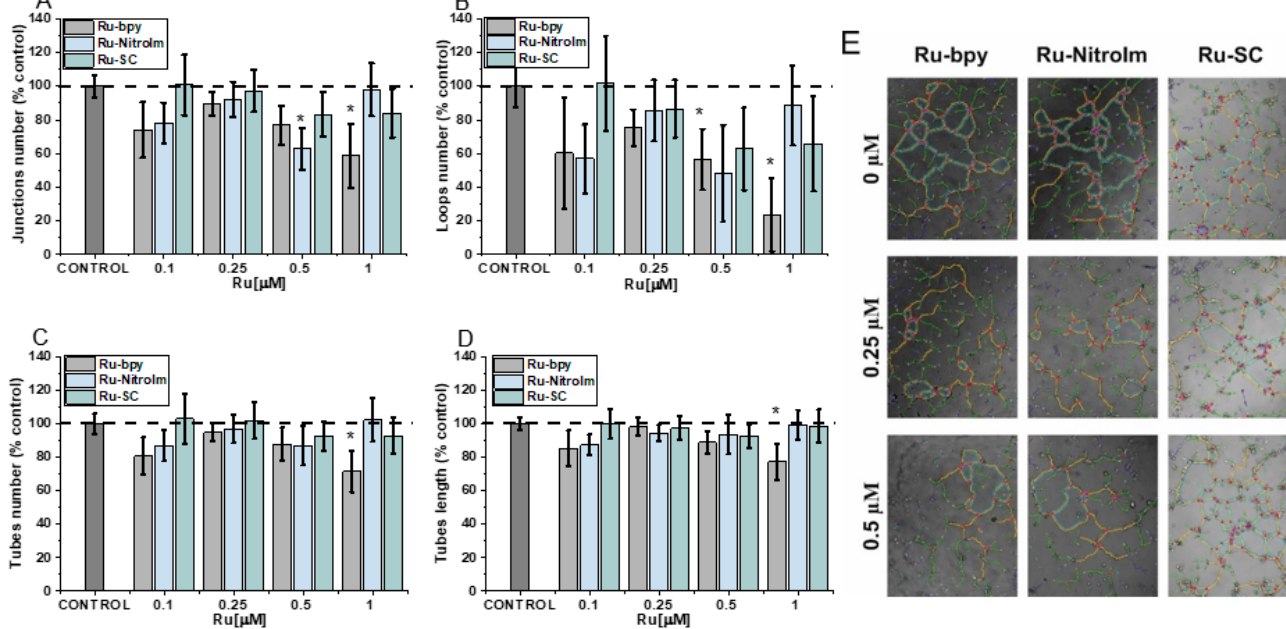
Figure 2. The influence of [Ru(dip) 2 (bpy)]Cl 2 (Ru-bpy, gray), [Ru(dip) 2 (bpy-NitroIm)]Cl 2 (Ru-NitroIm, blue) and Ru(dip) 2 (bpy-SC)]Cl 2 (Ru-SC, green) on the angiogenesis process in HMEC-1 endothelial cells, expressed as ( A ) a number of junctions, ( B ) a number of loops, ( C ) a number of tubes, ( D ) a length of tubes and ( E ) microscopic images after analysis in ImageJ. The results were calculated relative to the control cells (100%). * p < 0.05.